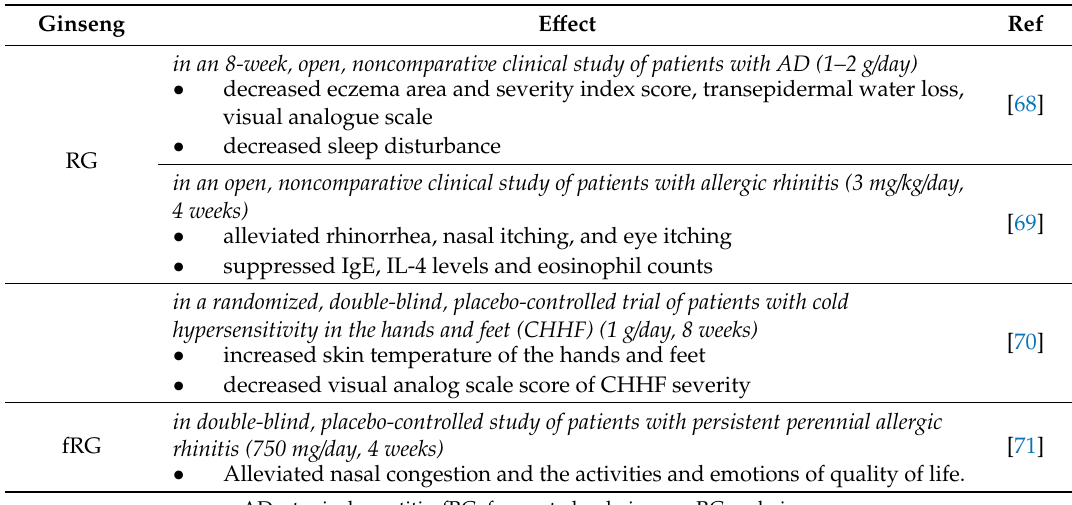
Table 2. Summary of ginseng extract e ff ects on allergic